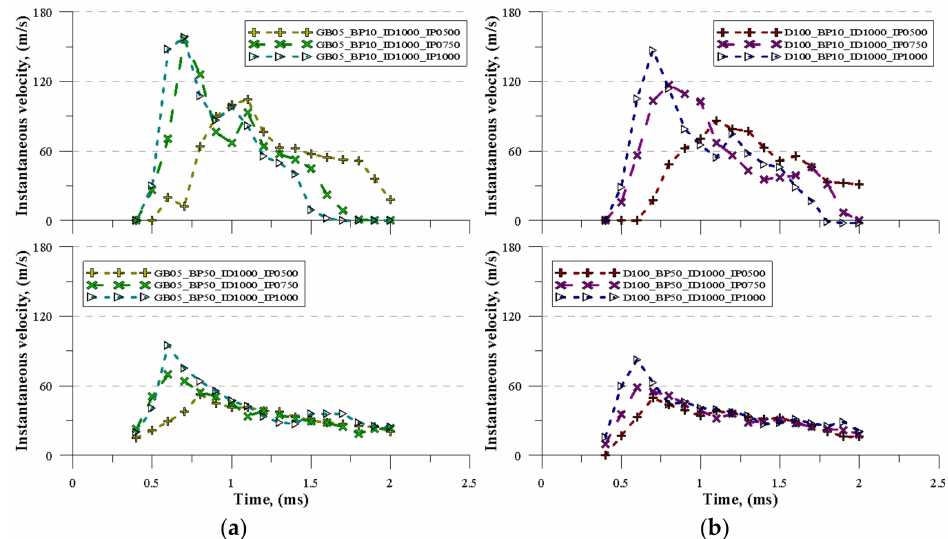
Figure 10. Instantaneous velocity of spray penetration of ( a ) GB05, and ( b ) D100 with an injection duration 1000 µ s at back pressures of 10 and 50 bar and injection pressures of 500, 750 and 1000